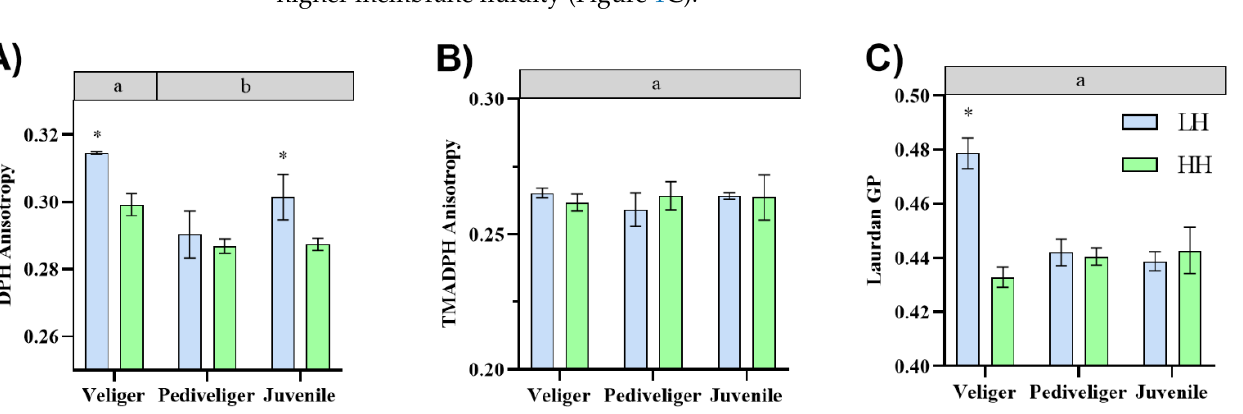
Figure 1. Effect of diets low (LH) and high (HH) in HUFAs on the fluidity of cellular membranes of larvae and juveniles of the scallop Argopecten purpuratus . Cell membrane fluidity was measured through the anisotropy of ( A ) DPH (1,6-diphenyl-1,3,5-hexatriene) and ( B ) TMA-DPH (1-(4-trimethylammonium)-6-phenyl1,3,5-hexatriene), and by ( C ) Laurdan PG (generalized polarization) using fluorescence spectroscopy analysis. Different lowercase letters show significant differences among developmental stages ( p < 0.05). Asterisks (*) indicate significant differences between dietary treatments within each developmental stage ( p < 0.05); n = 3 pools per